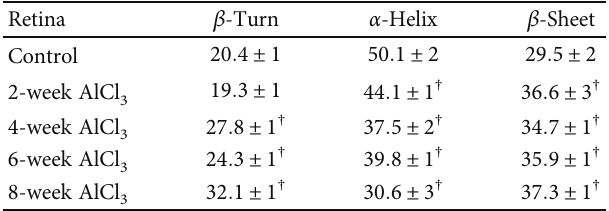
† Statistically signi fi cant ( n = 10 , p < 0 : 05